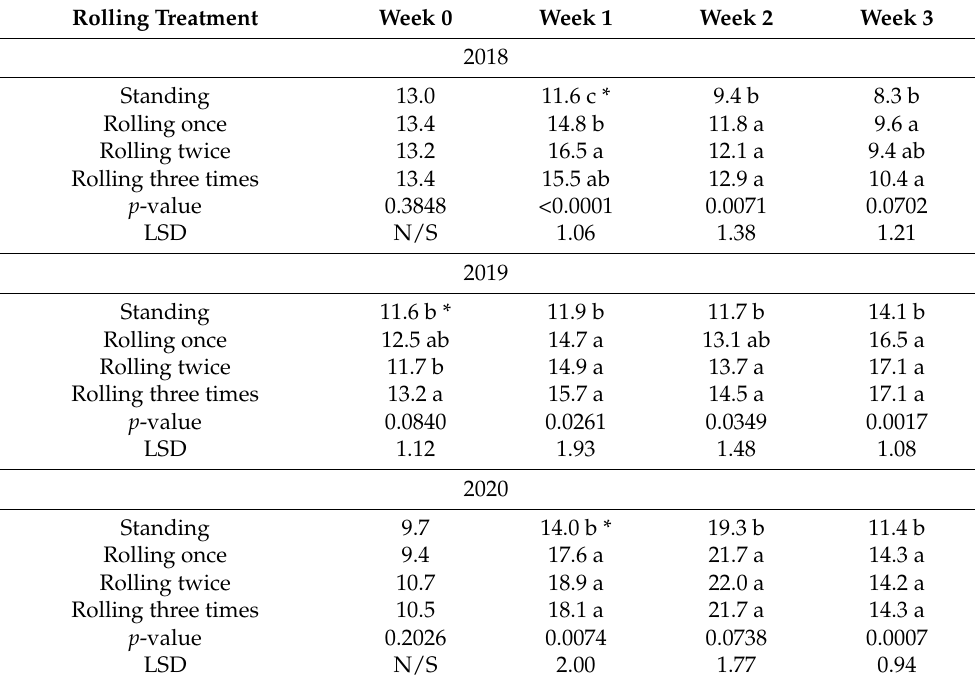
Table 8. Soil volumetric moisture content (%) in 2018, 2019, 2020 growing season assessed from rolling treatment application up to three weeks after